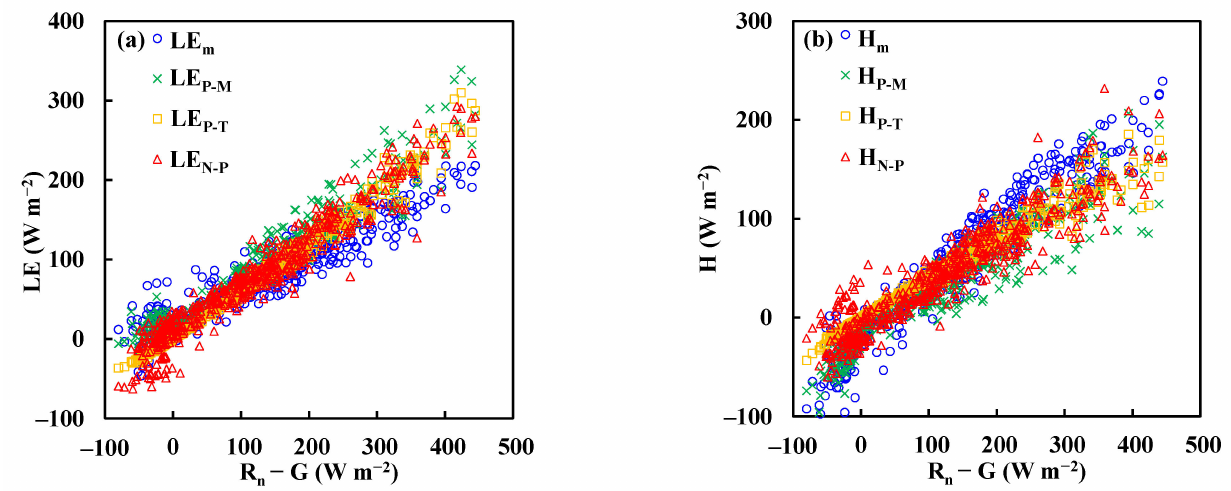
Figure 7. Scatter plots of measured and model-predicted LE ( a ) and H ( b ) as a function of available energy (R n − G) above the peat bog.